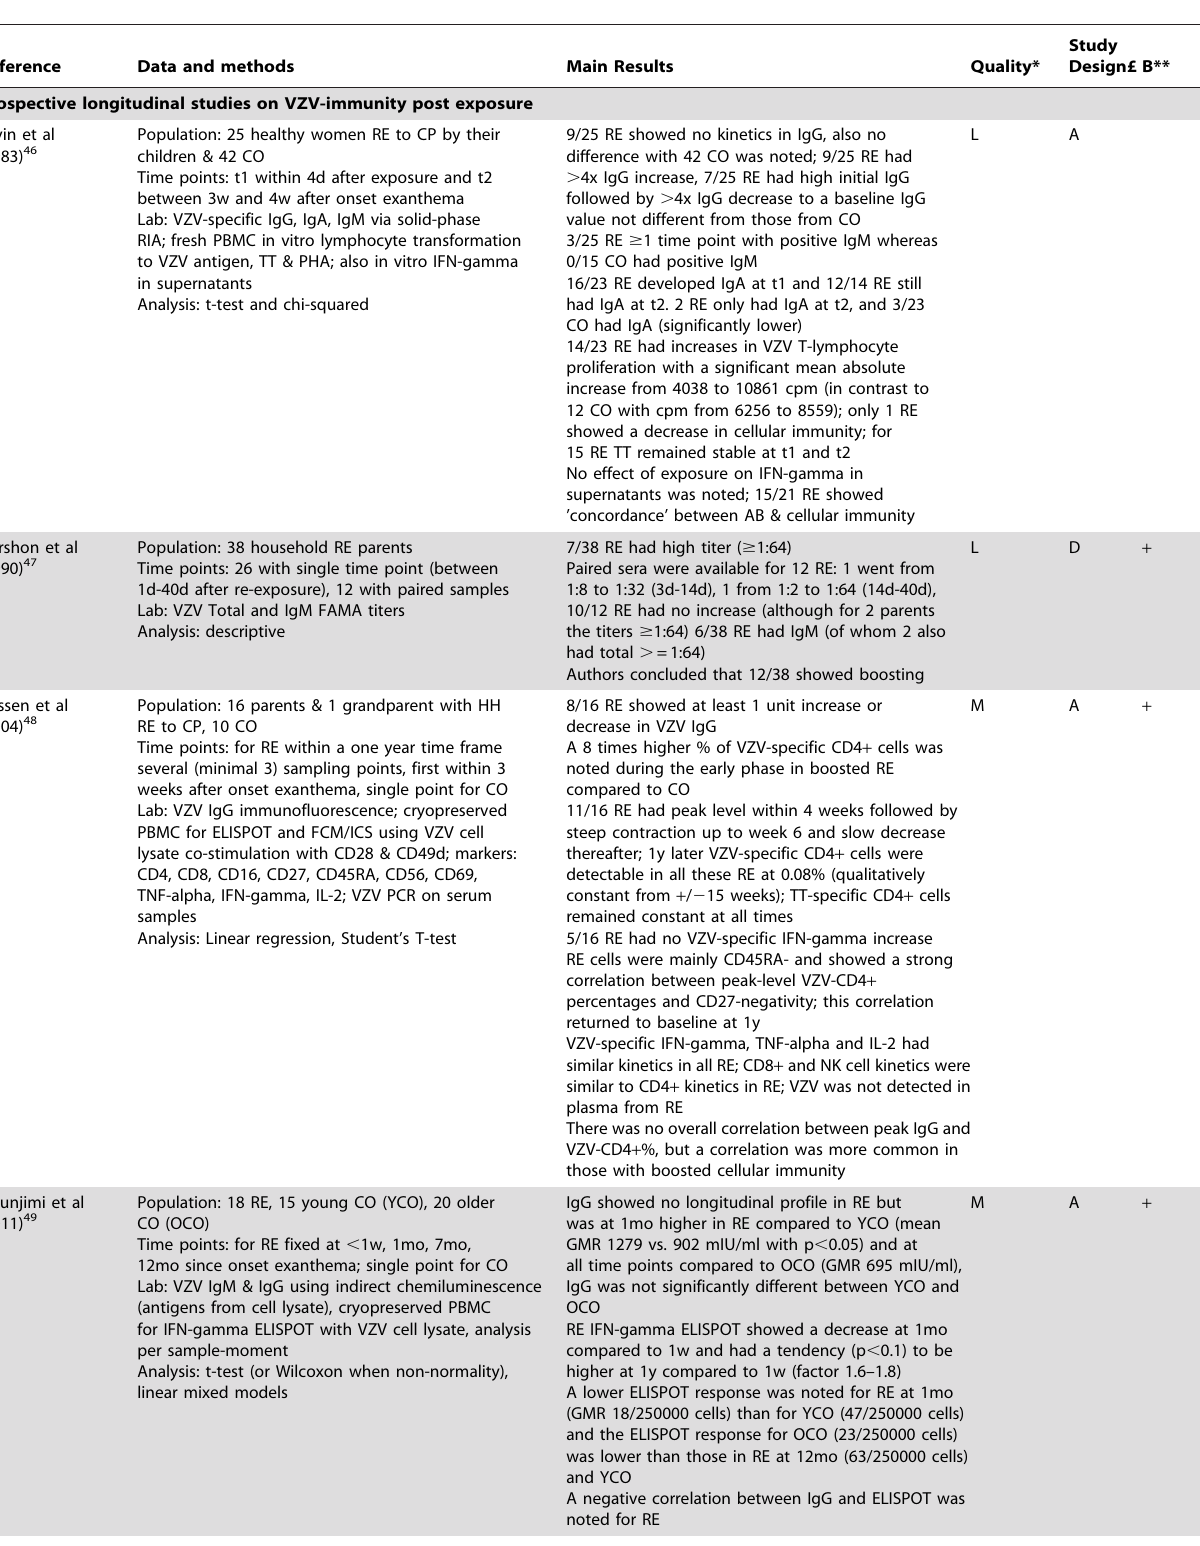
Table 4. Description of selected prospective longitudinal studies on VZV-immunity post exposure and other selected studies.